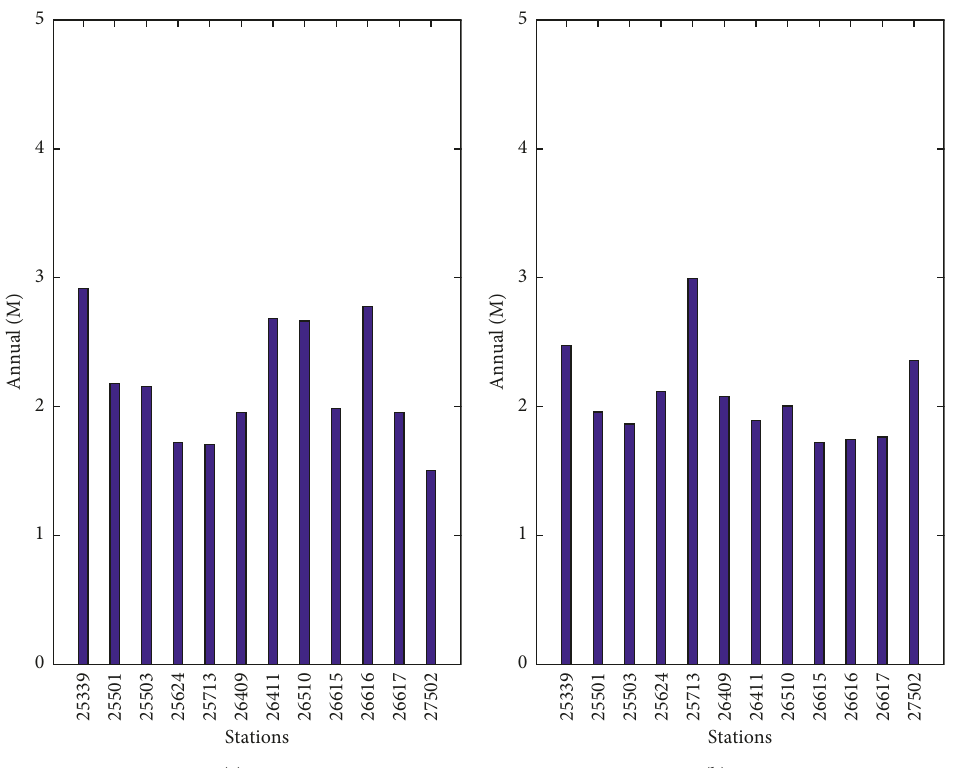
Figure 4: Annual average intensity (M) distribution of atmospheric (a) surface ducts and (b) elevation ducts at 12 stations in